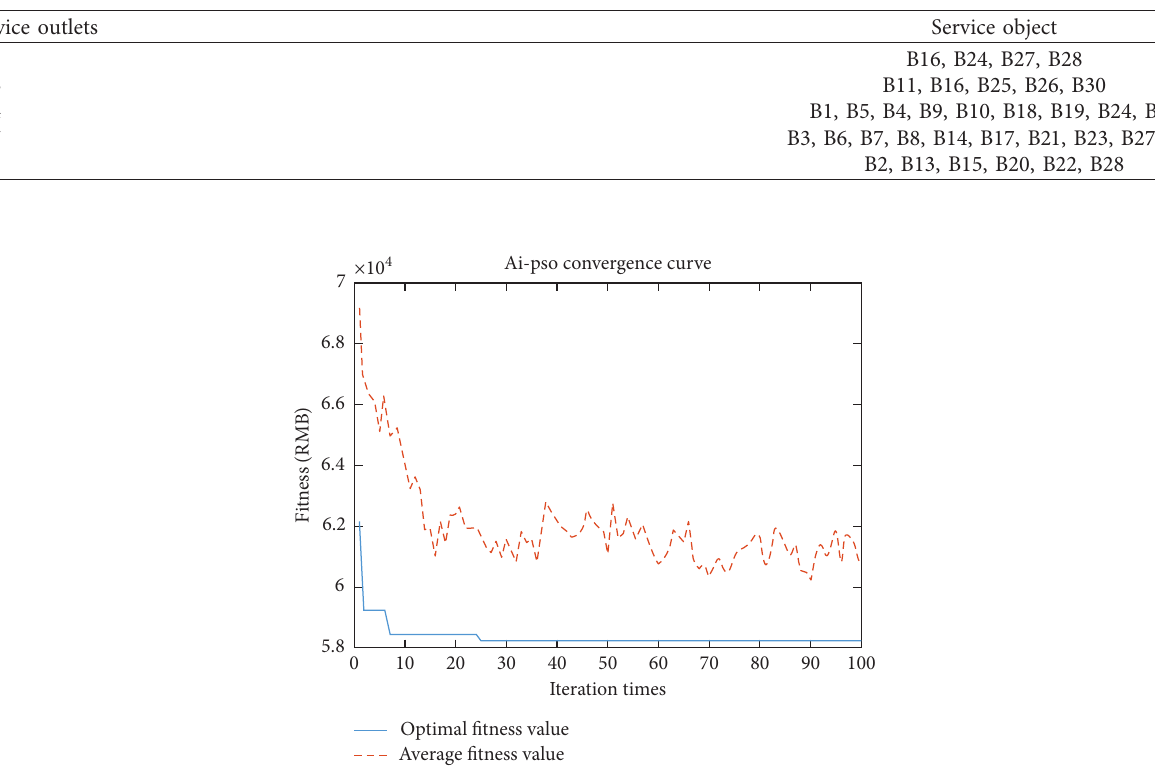
Table 8: Service object information of suppliers and distribution centers in a dynamic environment.